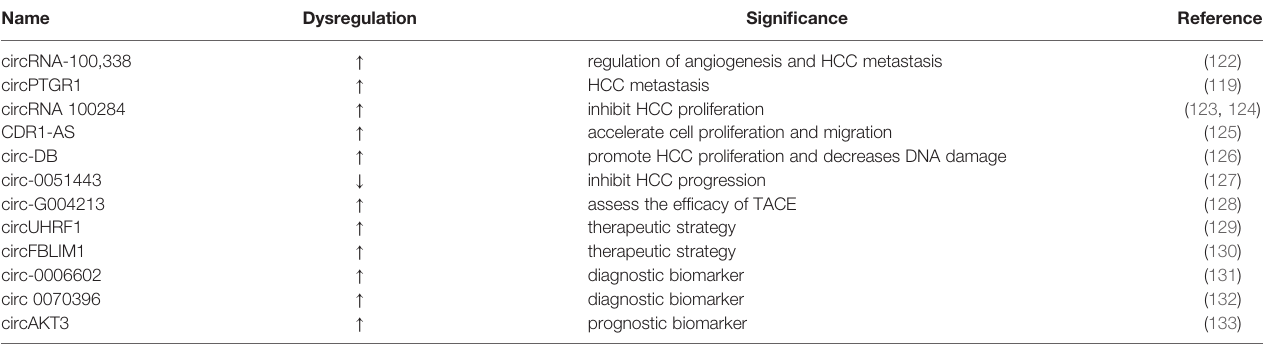
TABLE 2 | List of selected exosomal CircRNAs and their role in liver